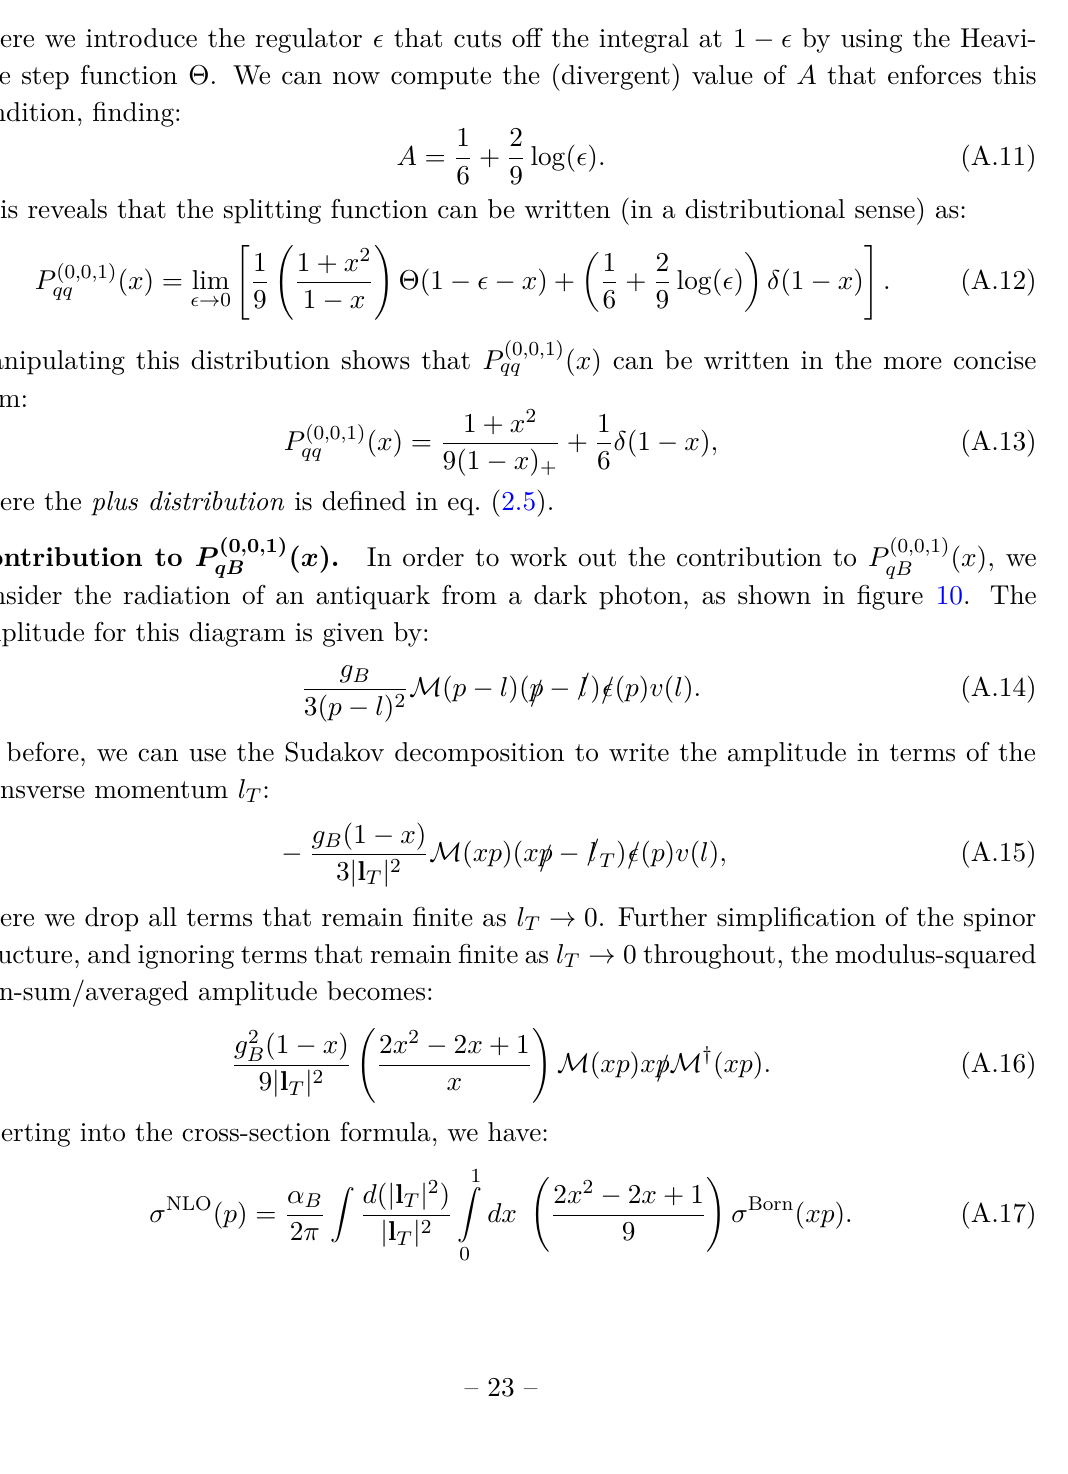
Figure 10 . Feynman diagram corresponding to real radiation of an